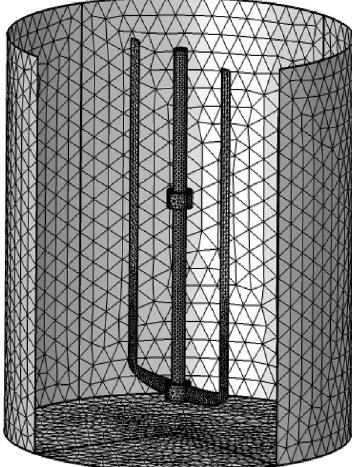
Figure 3. Unstructured mesh.